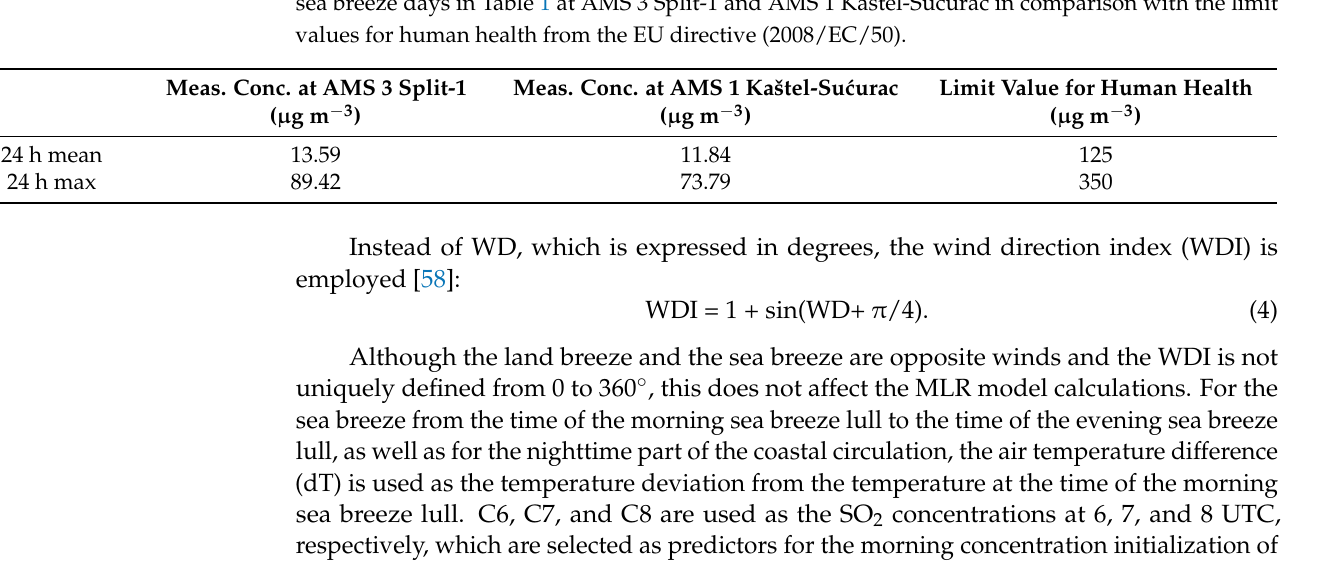
Table 2. The measured 24 h average and maximum (max) values of SO 2 concentration for the